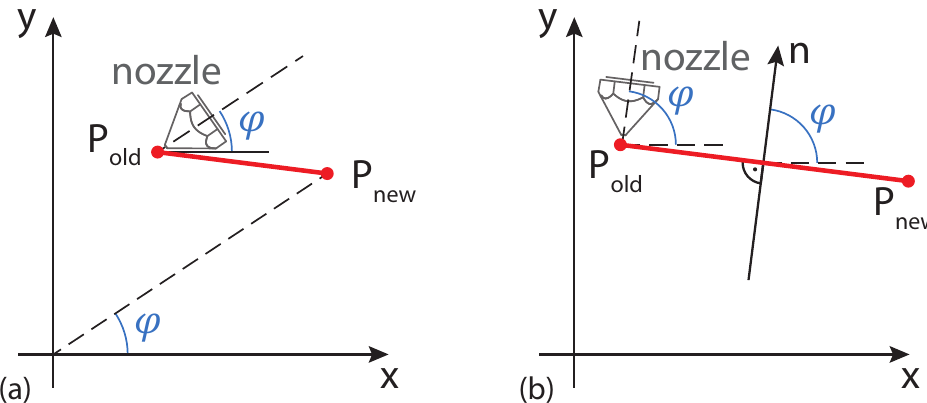
Figure 10. Orientation of the nozzle: ( a ) Nozzle with a radial orientation towards the origin and ( b ) Nozzle with a tangential orientation according to direction of